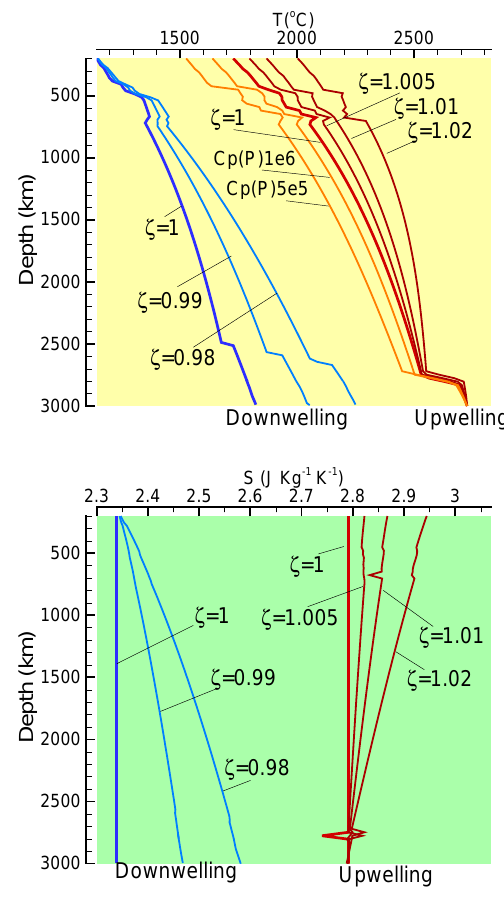
Figure 4. The upper panel shows the reversible and JT irreversible adiabatic temperature gradients in the Earth’s mantle for upwelling ( T at the bottom is 2727 ◦ C) and downwelling ( T at the top is 1150 ◦ C). The lower panel shows the change of entropy with depth. All cases assume the heat capacity at 1bar except the profiles with the label C p (P) (see main text for further details). Bold lines high- light the isentropic